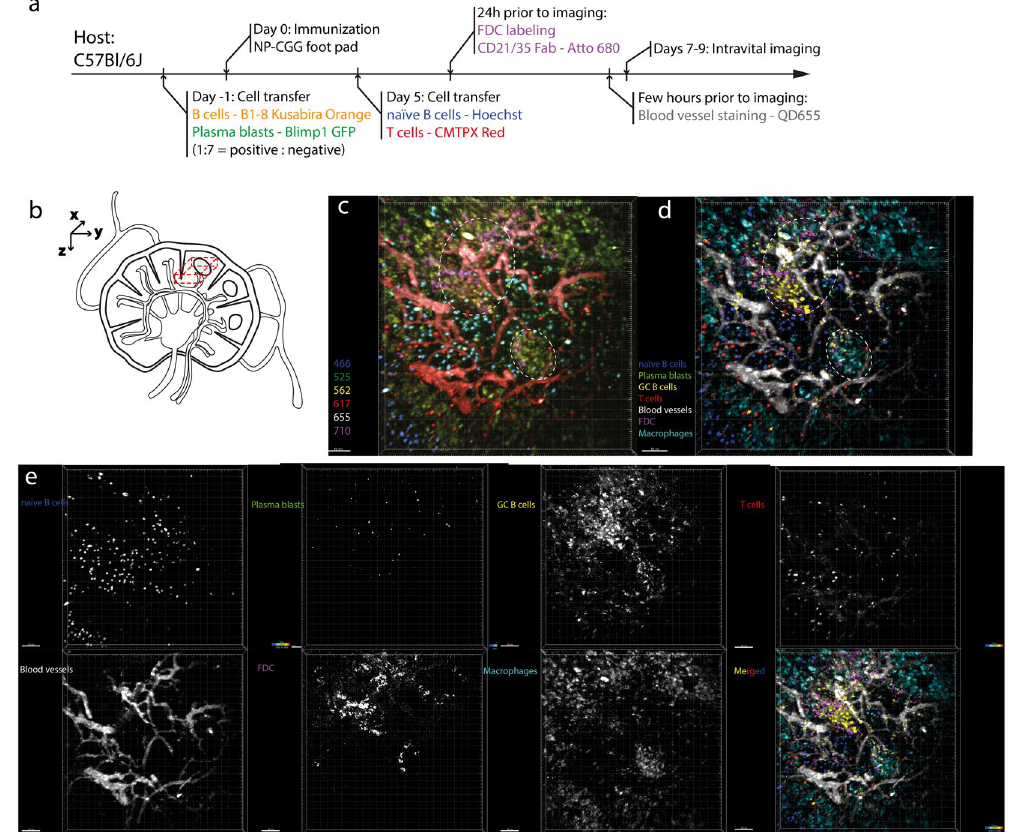
Figure 6. Dynamic multiplex in vivo imaging of germinal centers in the lymph node. ( a ) Preparation scheme of six-color mouse model. ( b ) Imaging region of popliteal lymph node (dashed 3D volume). ( c ) Raw 3D fluorescence images (500 × 500 × 40 µ m³) in the popliteal lymph node of a recipient mouse prepared as described in ( a ) – NP-CGG immunization, imaging at day 7 after immunization. The time-lapse 3D images are recorded in six channels: 466 ± 20 nm (blue), 525 ± 25 nm (green), 562 ± 20 nm (orange), 617 ± 35 (red), 655 ± 20 (grey), 710 ± 20 (magenta). Dashed circles represent ongoing germinal centers identified by the accumulation of B1-8 cells and FDC cells. ( d ) SIMI-unmixed 3D fluorescence image of ( c ). The unmixed image contains seven distinct cellular and tissue compartments (Hoechst – naïve B cells, Blimp1 + plasma blasts – eGFP, GC B1-8 cells - Kusabira Orange, CD4 + T helper cells – CMTPX Red, blood vessels – QD655, FDCs CD21/35 – Atto 680, tingible body macrophages – autofluorescence due to phagocytosis). ( e ) Individual fluorophore channels of the seven tissue compartments in grey scale. Scale bars, 50 μ